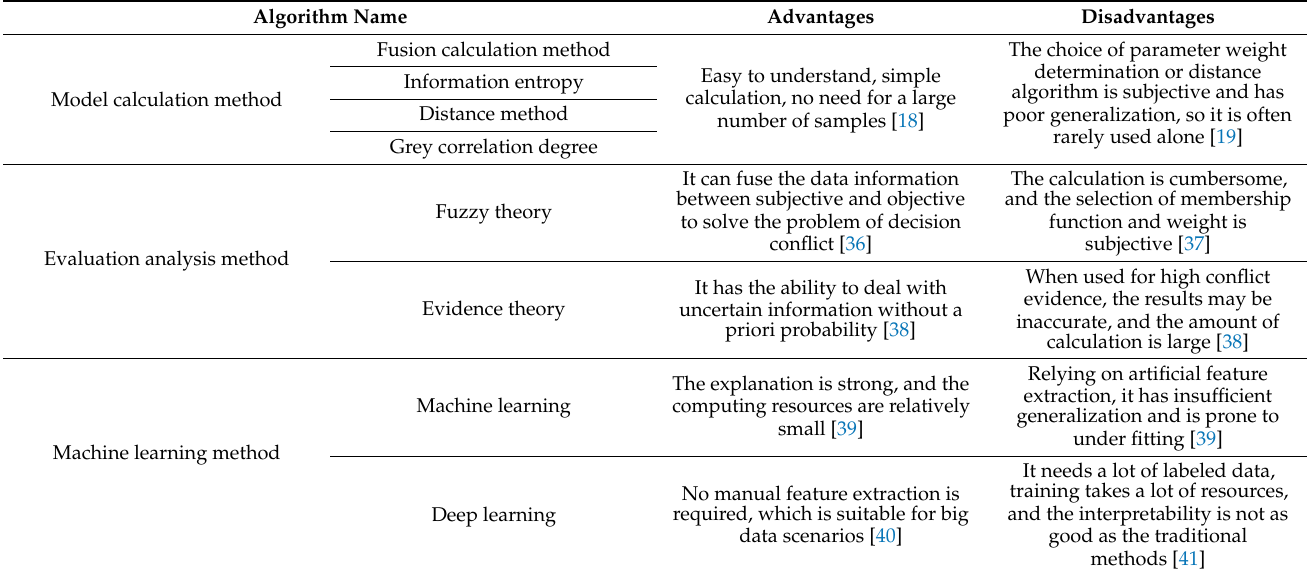
Figure 2. Classification of remaining life prediction methods. Table 3. Advantages and disadvantages of health state estimation